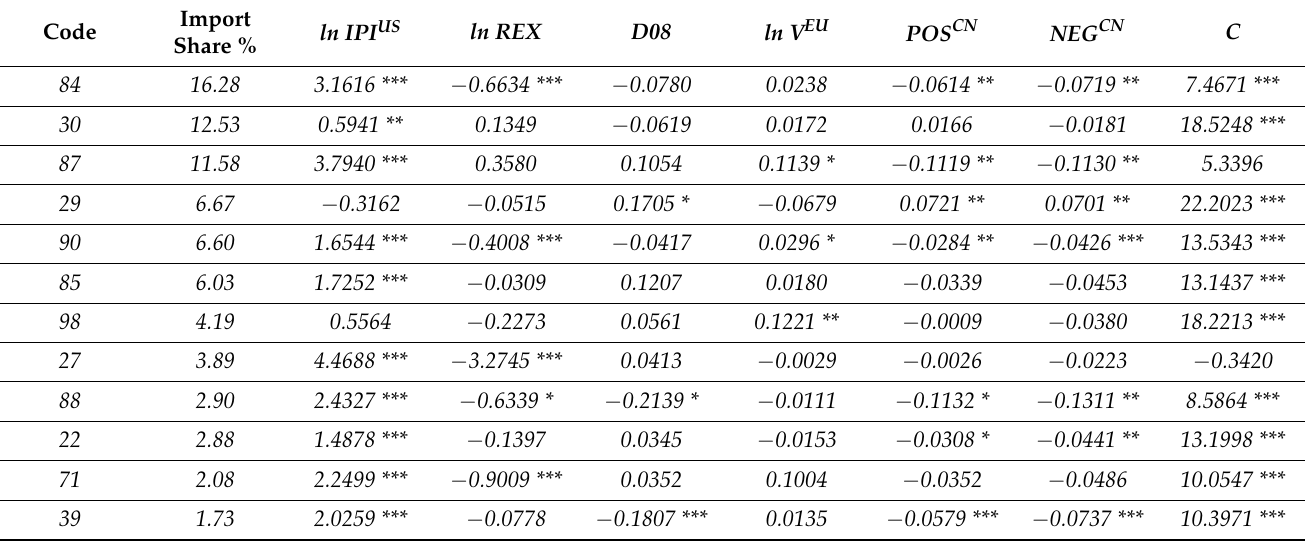
Table A2. Long-run coefficient estimates on the US imports from the EU with dummy and third Country effects in the nonlinear ARDL model